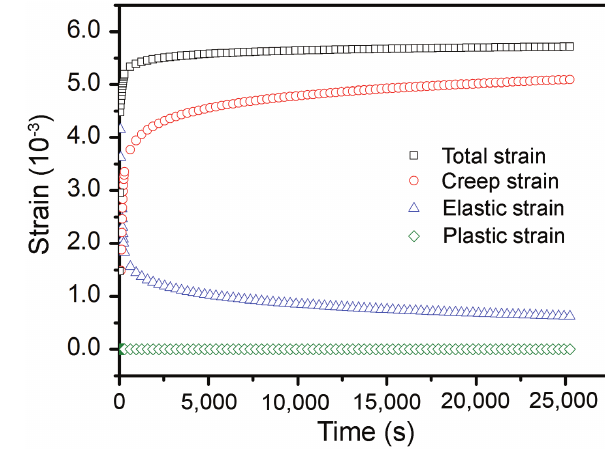
Figure 7: The evolutions of different types of strain